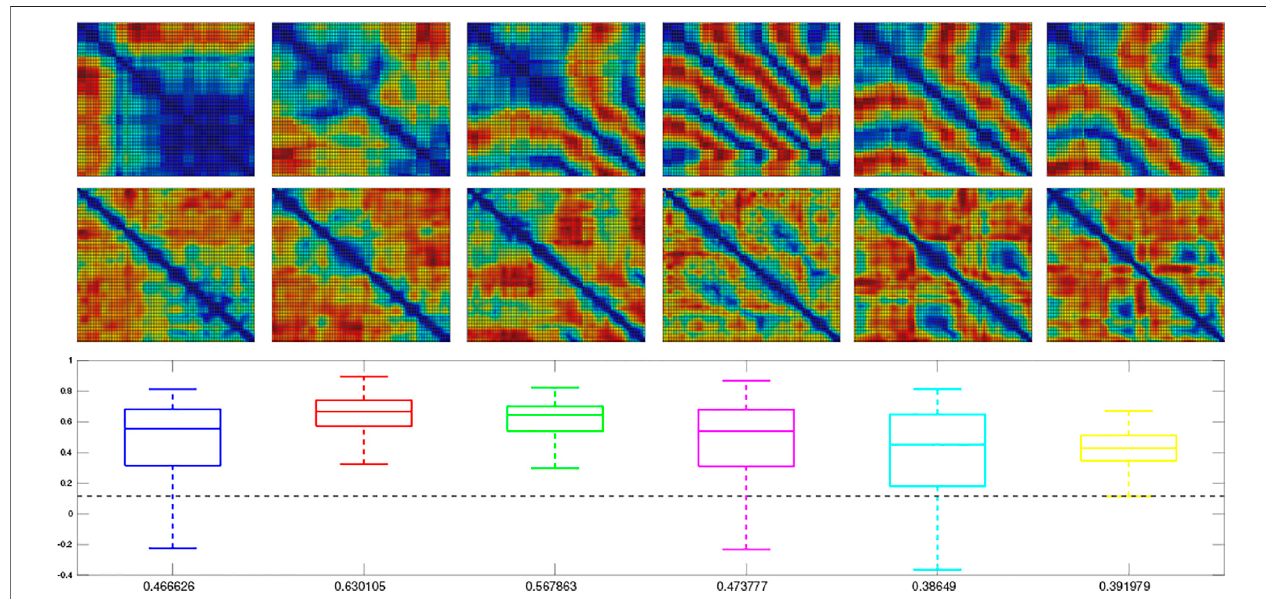
FIGURE 6 | Representation Similarity Analysis applied to each of the 6 test sets sampled from the simulator and inferred by a trained MultiPredNet Model using samenetworktopologyasforphysicaldatasets.Toprow)RepresentationDissimilarityMatrices(RDMs)forthe fi rst100samplesofposefromeachset(1 – 6lefttoright). Middlerow)RDMsforthe fi rst100inferredjointlatentrepresentationsfromeachset.Lowerpanel)BoxplotssummarisingtheSpearman ’ sRankcoef fi cient( ρ )calculated forthefull400samplesofeachtestset.Thecolourofeachboxplotisthesamecolourasquiverplotsforeachtestsetshownin Figure3 ,withtheblackdashedline indicating signi fi cance ( p < 0.001, n (cid:1) 400). The mean value of ρ for each set is printed beneath each box plot for clarity.